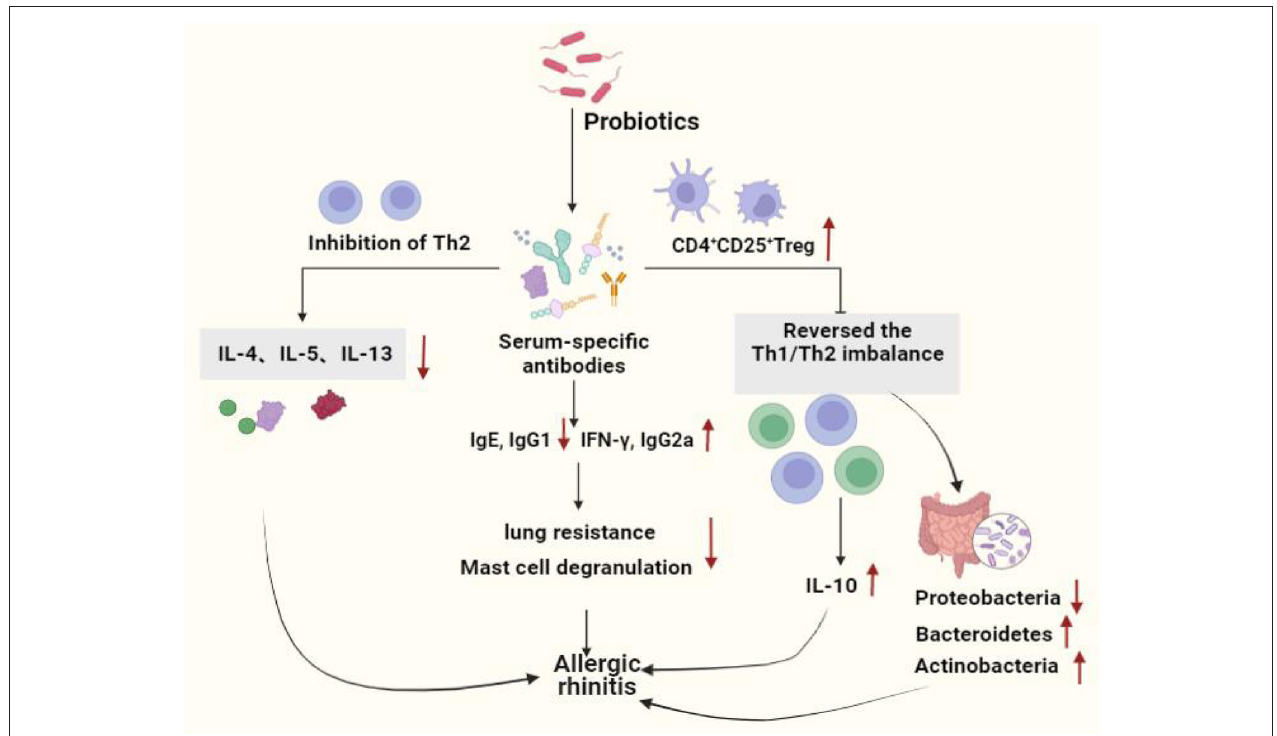
FIGURE 2 | Effect of probiotics on allergic rhinitis. Probiotics protect the allergic rhinitis by decreasing inflammation in serum and lung tissue, increasing the number of immune cells, immune system homeostasis by regulating the Th1 and Th2 balance and increasing the number of Tregs. Moreover, probiotics regulated intestinal stability by increasing the level of beneficial bacteria, hence improving AR. Th1, T helper 1; Th2, T helper 2; IL-4, Interleukin 4; IL-5, Interleukin 5;IL-10, Interleukin 10;IL-13, Interleukin13; IgG1, Immunoglobulin G1; IgE, Immunoglobulin E; IgG2a, Immunoglobulin G2a; IFN- γ , Interferon- γ